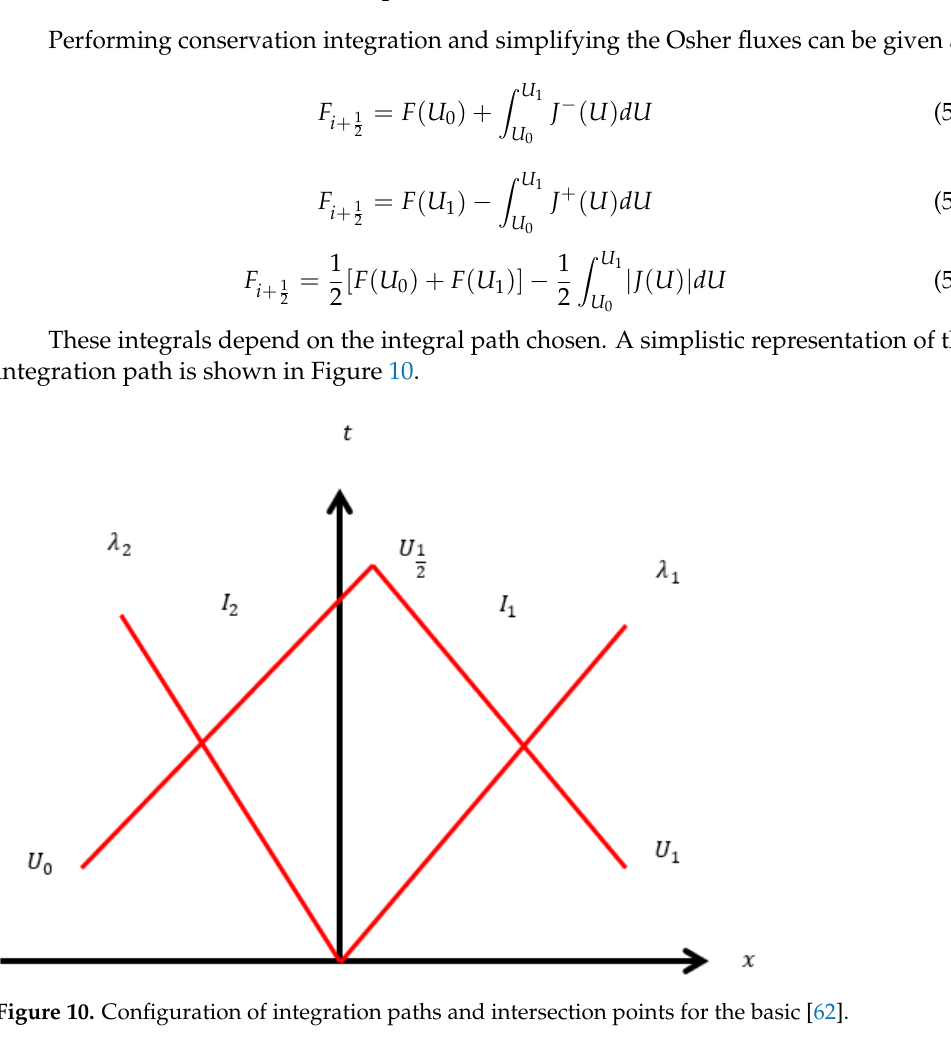
Figure 10. Configuration of integration paths and intersection points for the basic [62].